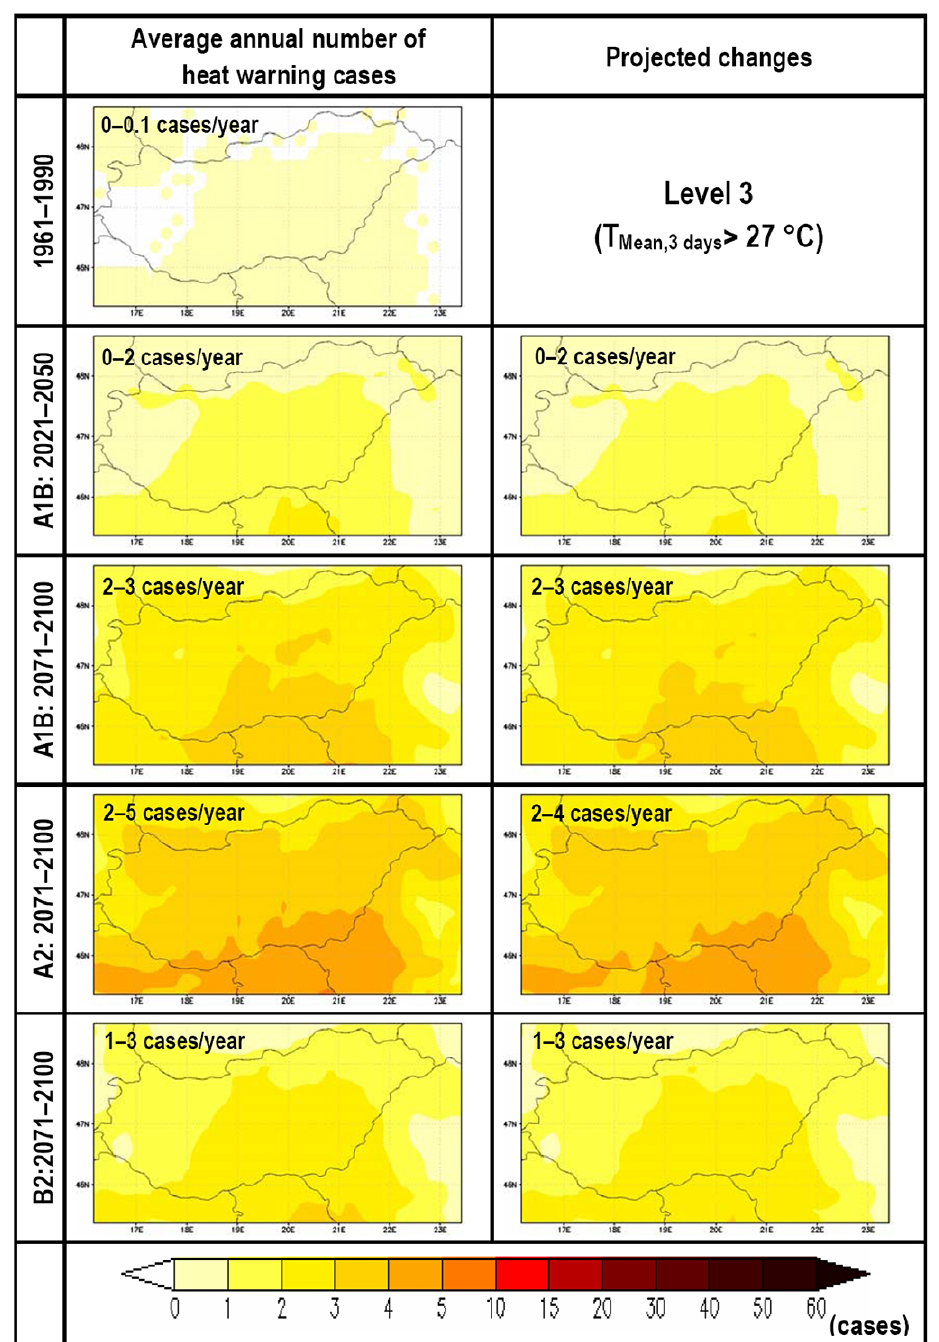
Fig. 4. Simulated occurrences of heat wave warning level 3 (left panel). Projected changes (right panel) are calculated relative to the 1961– 1990 reference